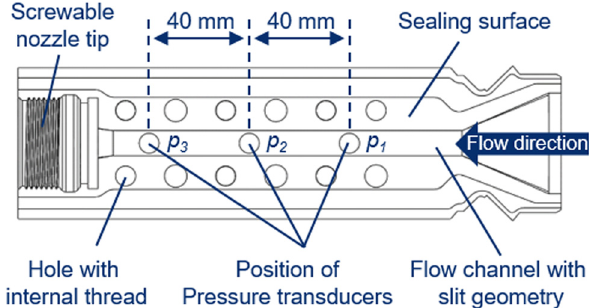
Figure 2: Schematic drawing of the in - line viscosity measurement die within the foam injection molding process, developed at the IKT [ 33,34,38 ]